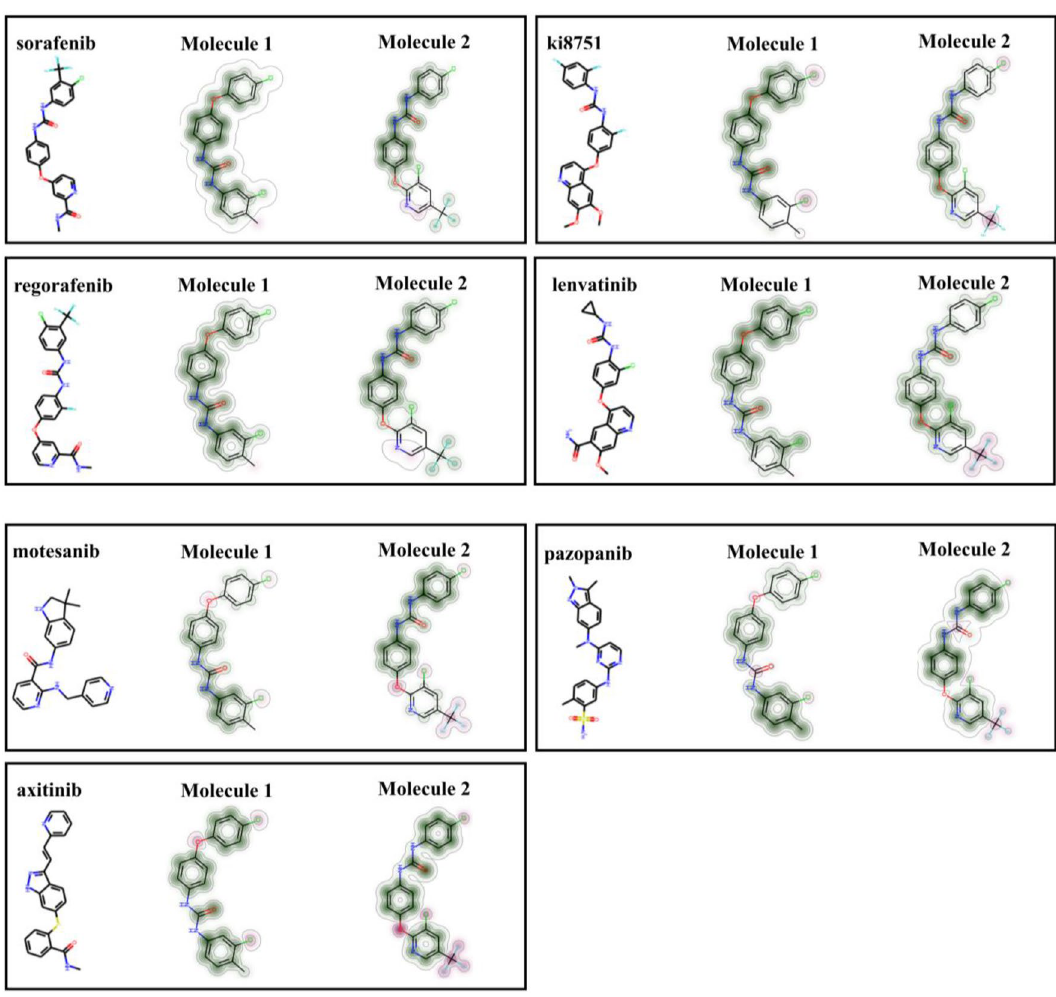
Figure 5. Similarity maps between sorafenib, Ki8751, regorafenib, lenvatinib, motesanib, pazopanib, and axitinib as references and candidates moelcule1 and molecule2 using the circular fingerprints (bit vector- based Morgan2). Coloring method: green: positive difference, gray: no change in similarity, and pink: negative difference. The figure is created by using Scikit-learn v 0.23.1, https:// scikit- learn. org. Statistical